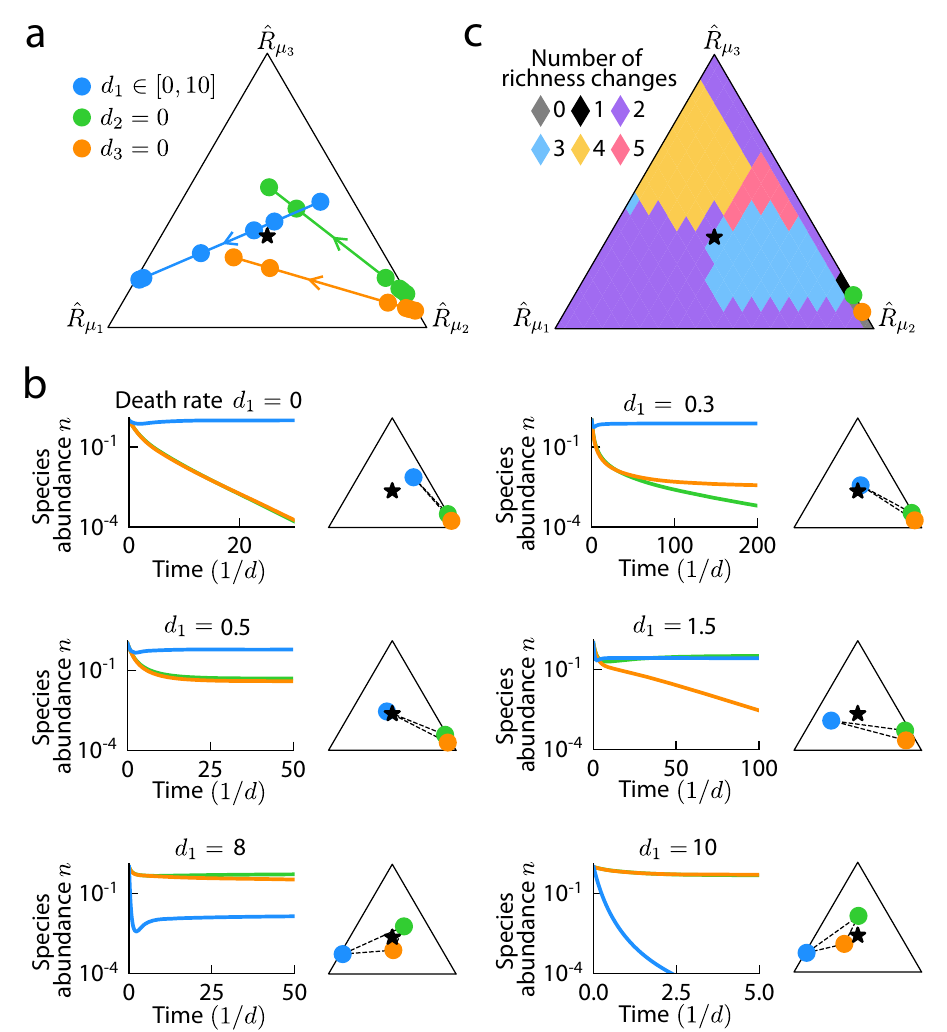
Fig. 3 | Richness can change non-monotonically with increasing death rate. a Trajectories of rescaled consumption rates as the death rate of the targeted species (blue) is increased. Arrow denotes the direction of increasing death rate. Circles mark the six death rates shown in ( b ). With increasing death rate, the tar- geted species eventually became more specialized, while the non-targeted species becamemoreofageneralistandclosertothesuppliedresourcepointatthecenter of the simplex. b Population dynamics at the six death rates marked in ( a ).( d 1 =0) Intheabsenceofantibiotictargeting,onlythebluespeciespersisted.( d 1 =0 : 3)For